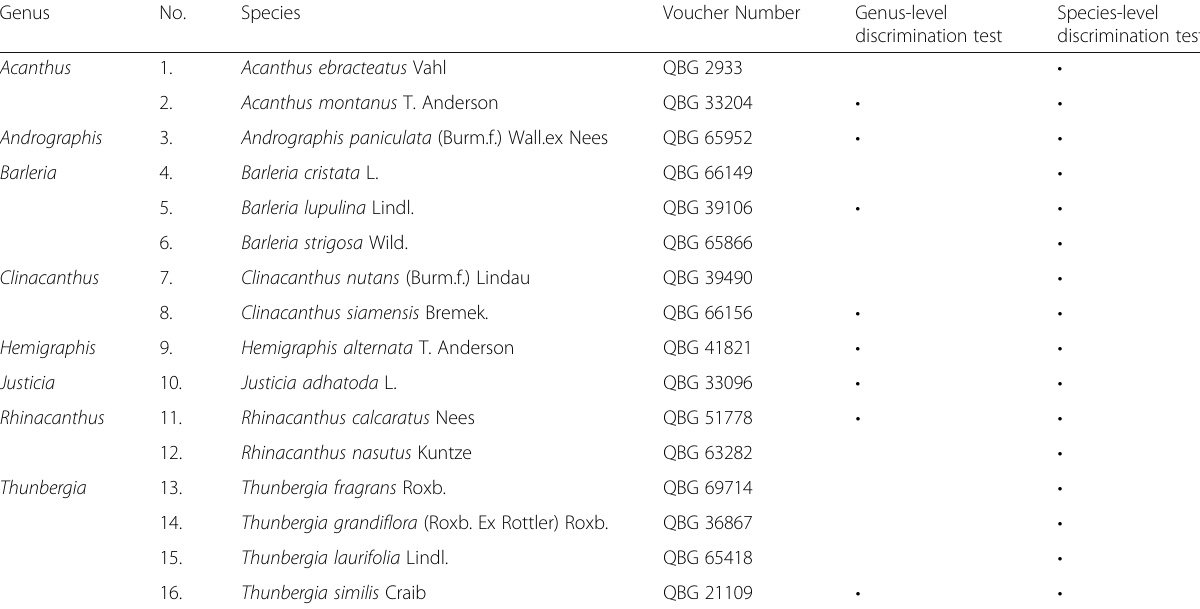
Table 1 List of medicinal plants species used in this study